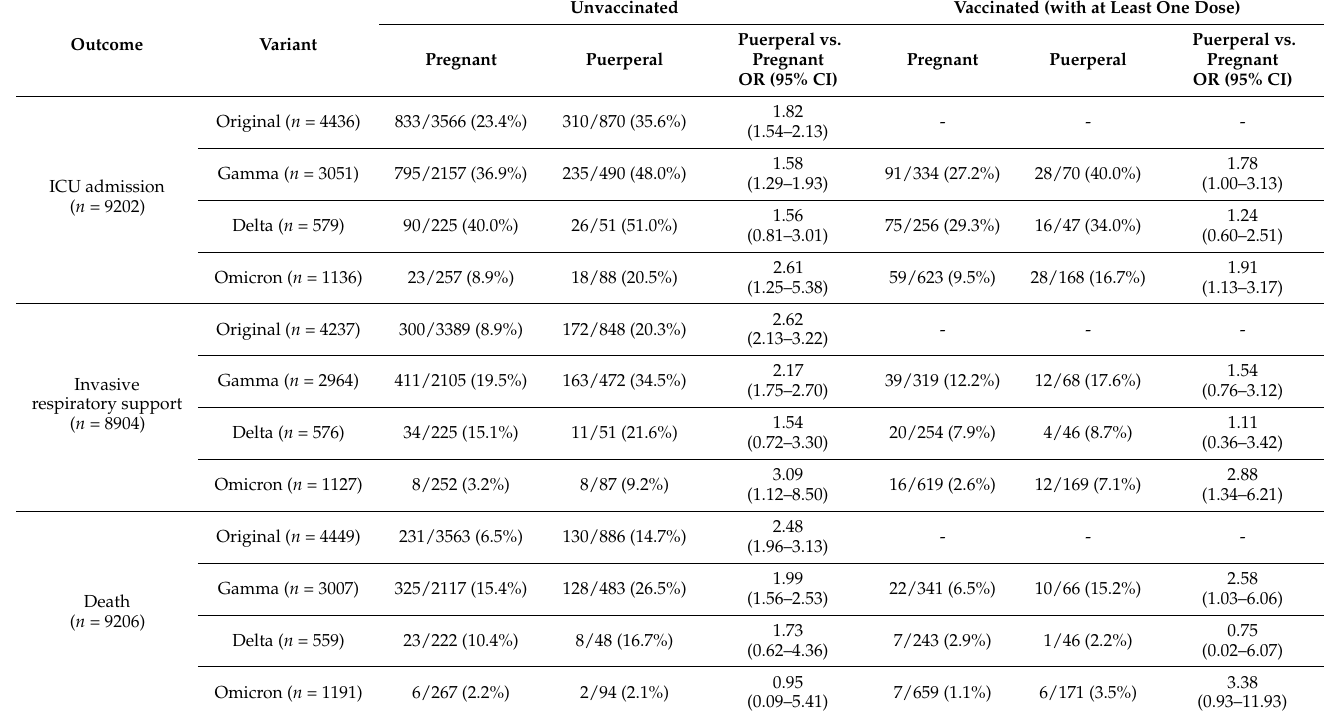
Table 3. Outcomes of pregnant and postpartum women with